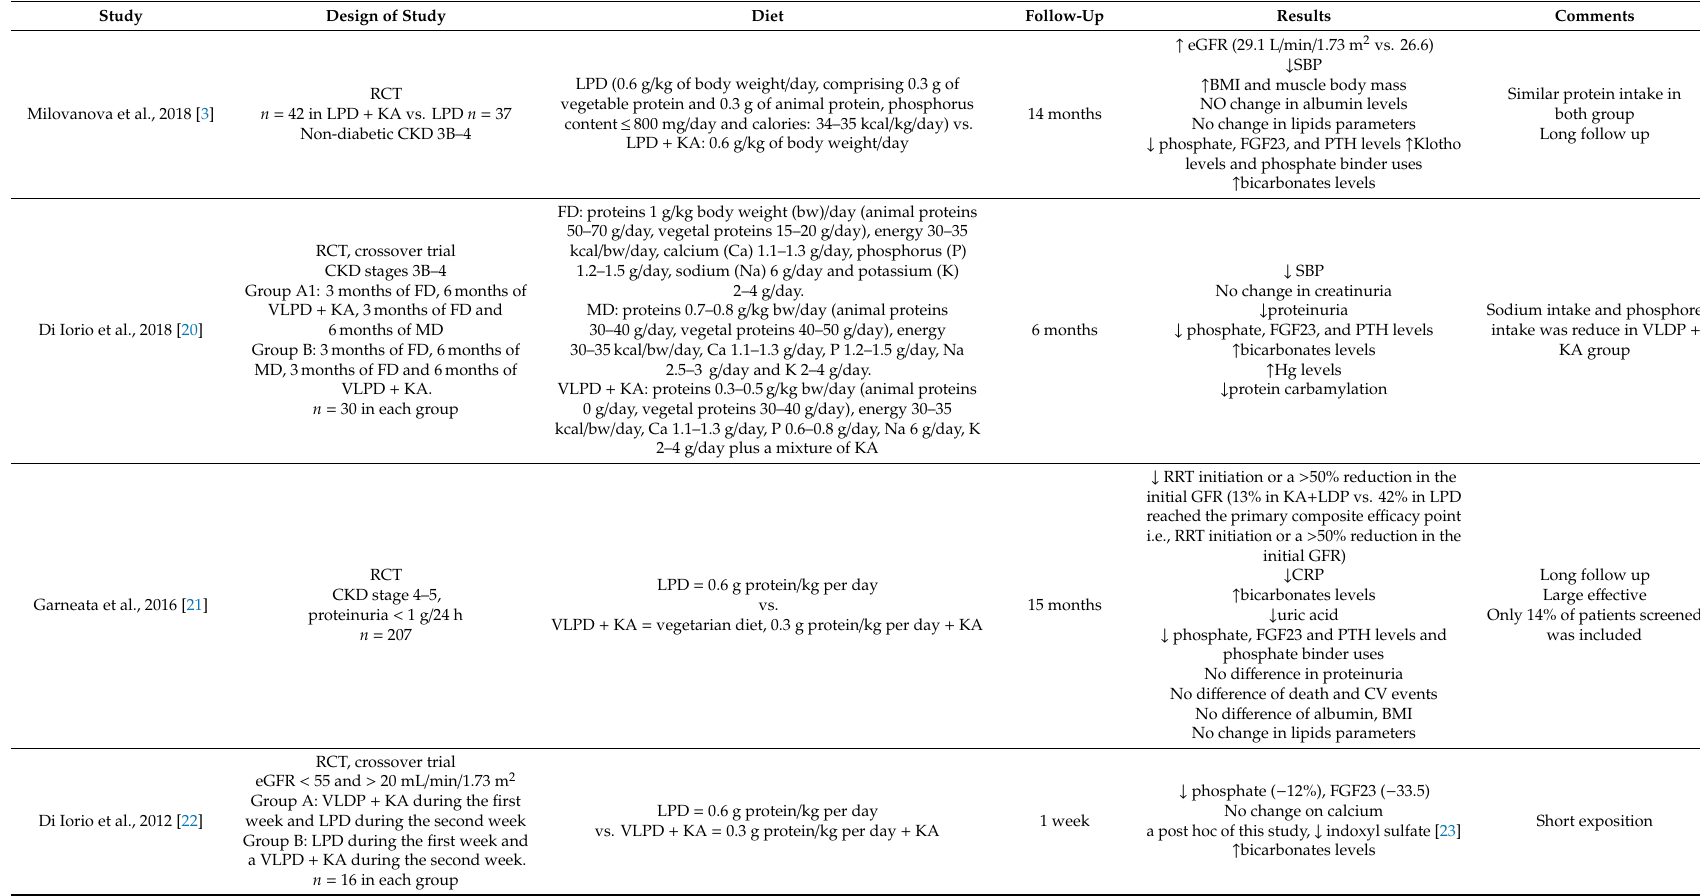
Table 3. Main RCTs that examined the e ff ects of LPD or VLDP / LPD supplemented with ketoacid analogues on various endpoints in non-dialysis patients with eDFG under 60 mL / min / 1.73 m 2